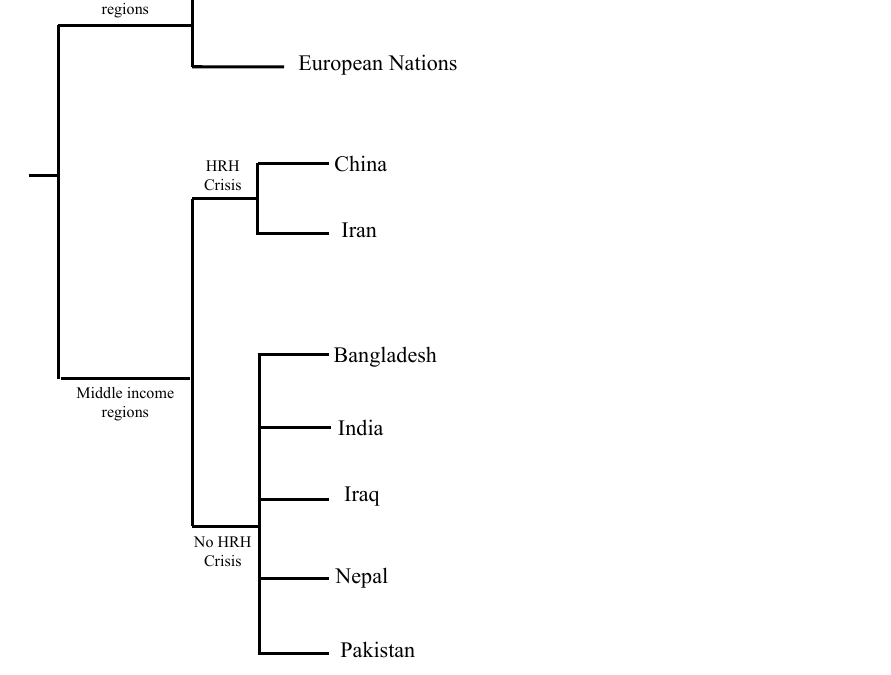
Figure 2. Income grouping of countries facing human resources for health crisis (HRH) according to World Health Organization (WHO) [32,33,34,35].